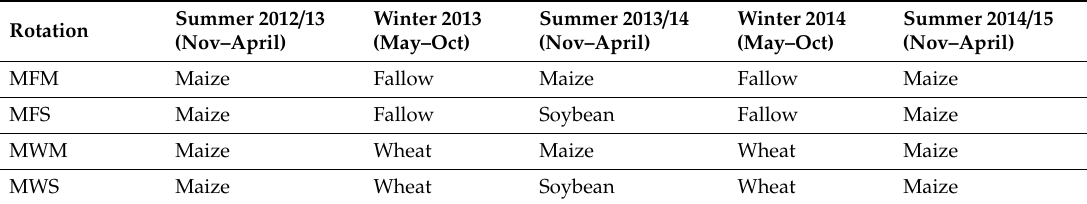
Table 2. Summary of crops grown in the experiment